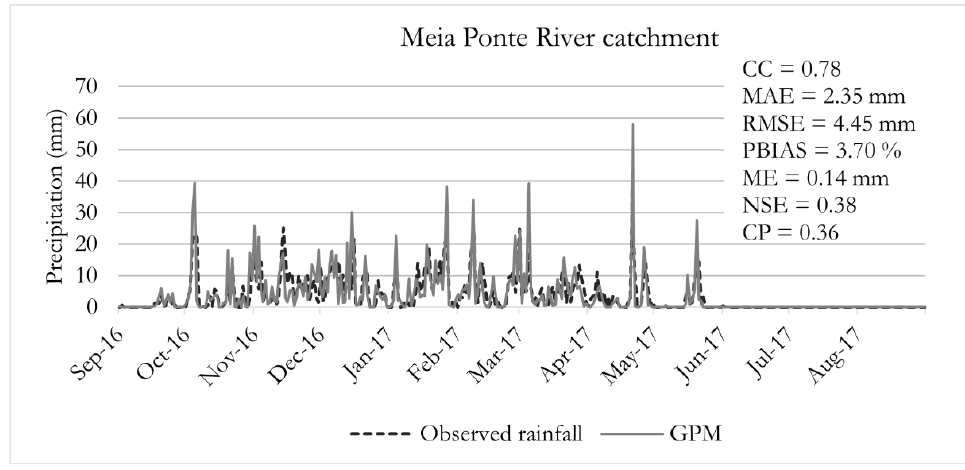
Figure 2. Comparison of the daily precipitation, as obtained from the GPM and the ground rainfall gauging network, averaged over the area of the Meia Ponte River catchment.